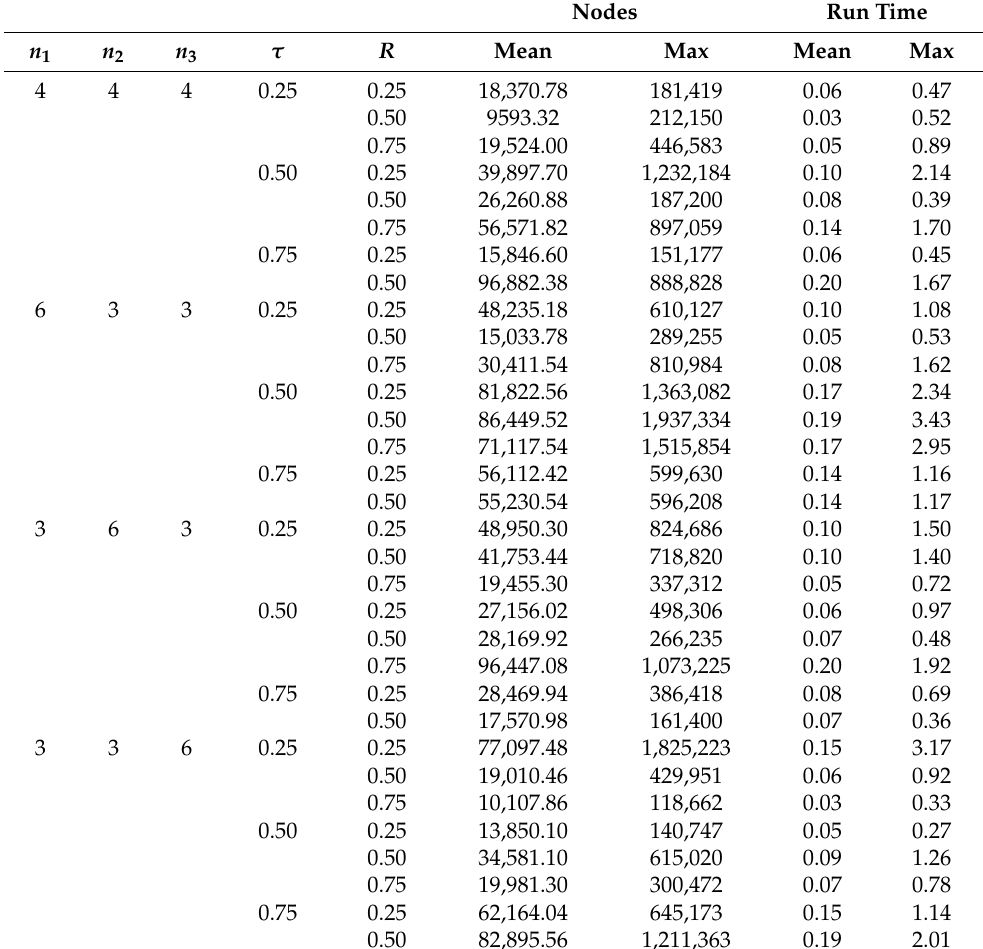
Table 5. The effects of different job types on the performance of BB for n = 12 and m = 3. Nodes Run